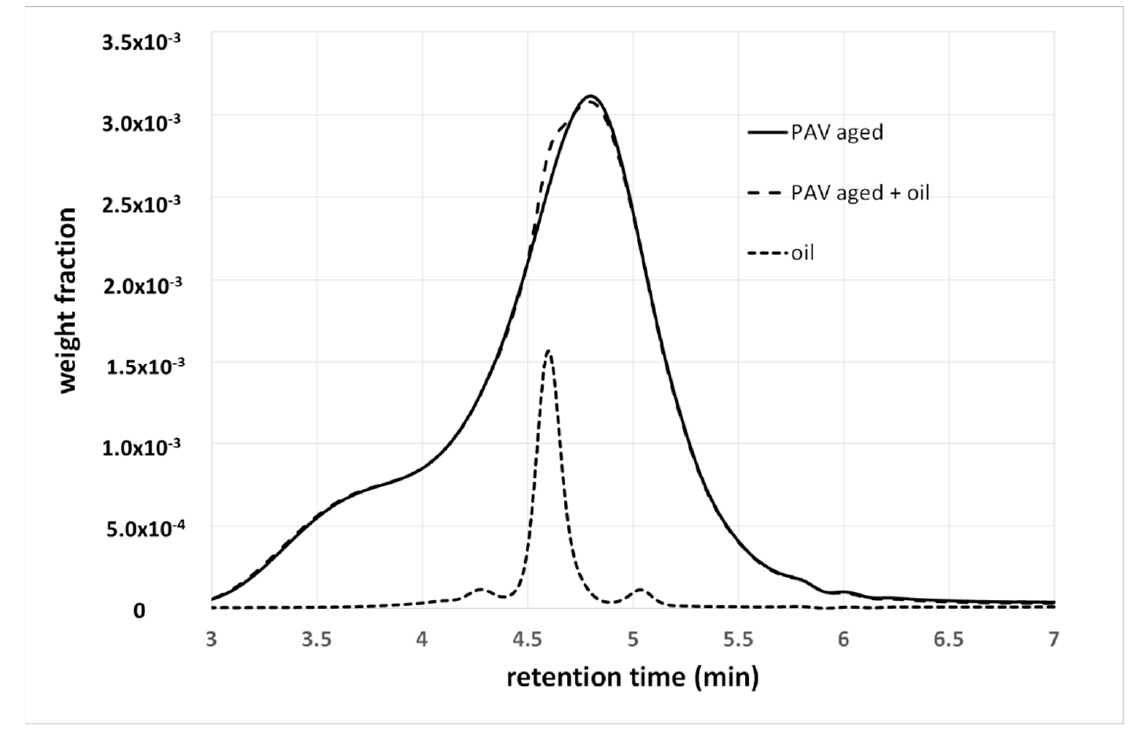
Figure 8. Weight fraction as a function of retention time of PAV-aged and rejuvenated binder, and of the rejuvenating oil. Details are given in [16,17].